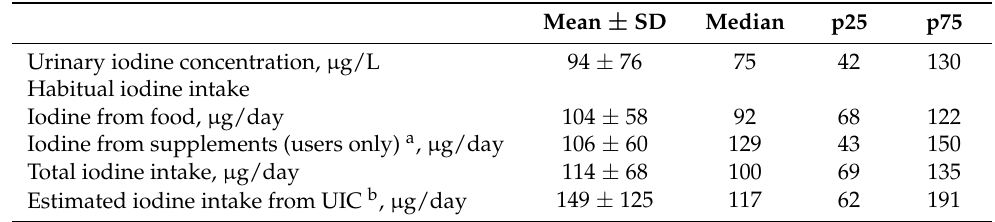
Table 2. Urinary iodine concentration and habitual iodine intake from food and supplements in young Norwegian women ( n = 403).